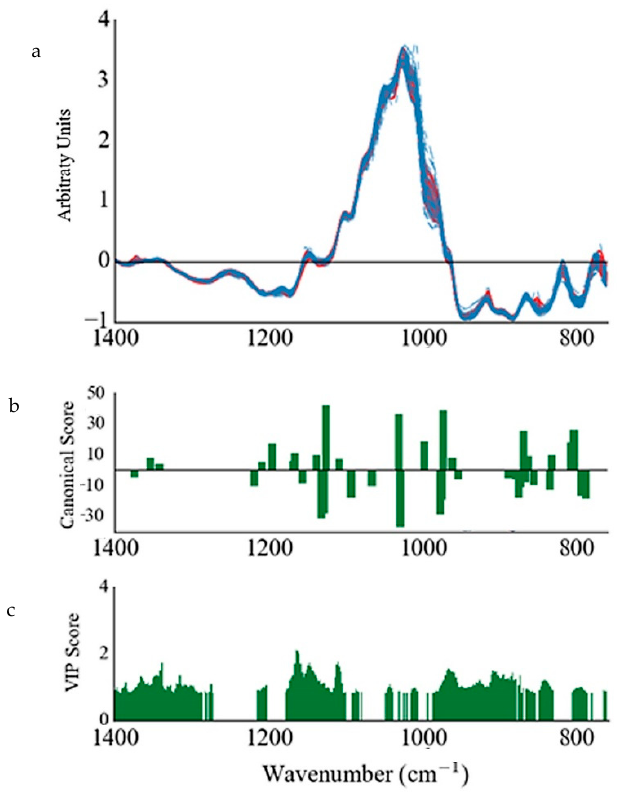
Figure 2. ( a ) SNVDT transformed ATR-FT-MIR spectra of fingerprint region of all honey samples (continuous red lines represent local samples and dashed blue lines represent foreign samples), ( b ) stepwise linear canonical discriminant analysis (SLC-DA) canonical scores and ( c ) VIP scores (>0.8) obtained from the variable selection procedures performed on the transformed spectra in ( a ).